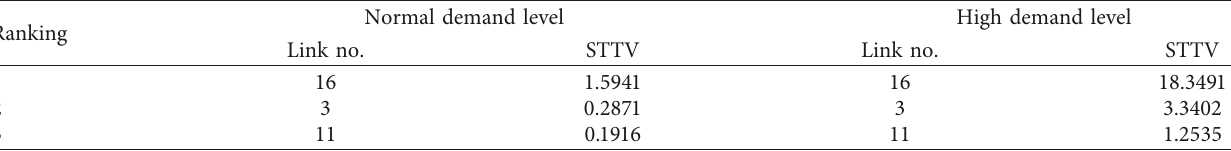
Table 8: The three most vulnerable links considering STTV value.